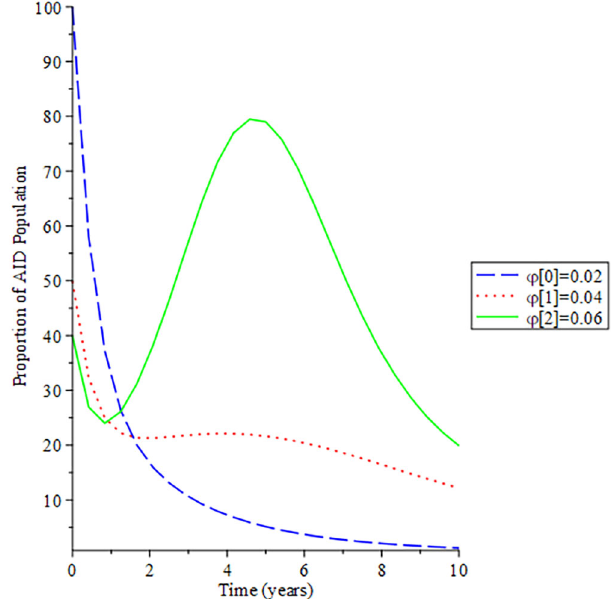
Figure 11. Behavioral dynamics of AIDS population when varying vertical transmission φ with time.